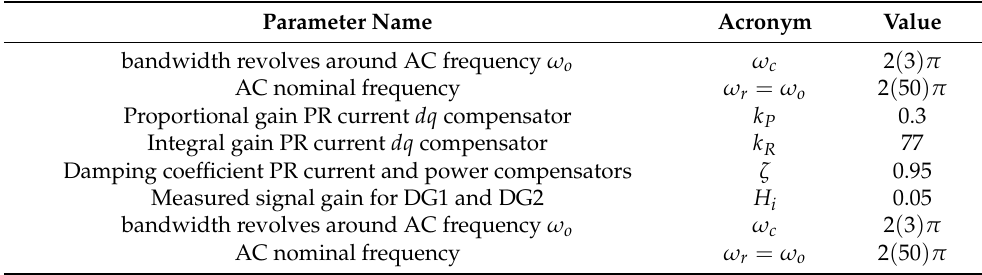
Table 2. The control parameters of the main converters.